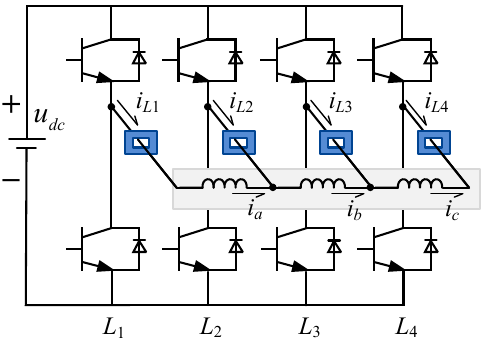
Figure 4. Leg currents and phase currents of a three-phase series-winding PMSM.